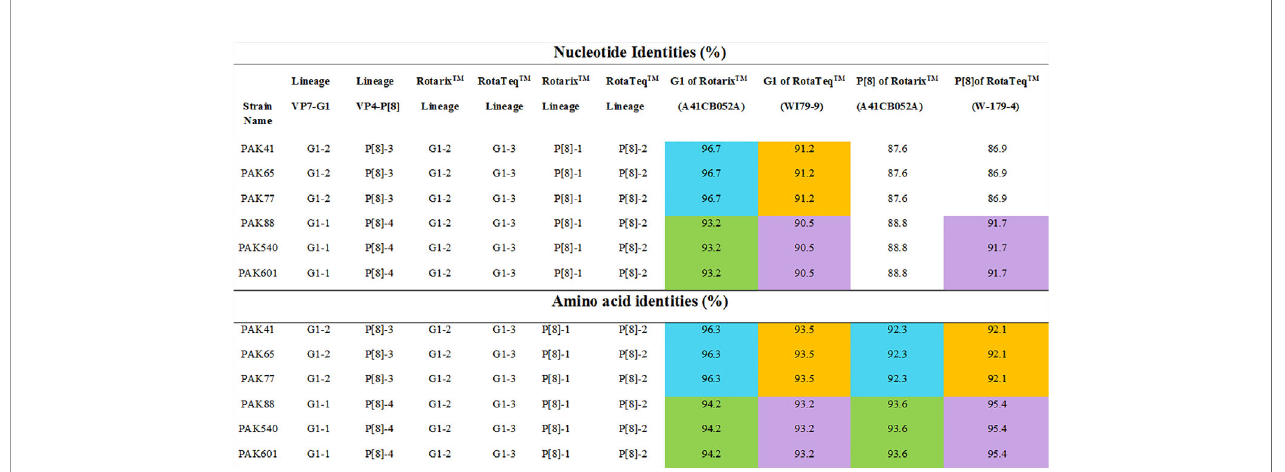
FIGURE 1 | The nucleotides and amino acids differences of VP7 and VP4 proteins of Pakistani G1P[8] strains with rotavirus vaccine strains. The similarities between G1 lineage I to Rotarix ™ and RotaTeq ™ vaccine strains is shown in green and purple colours, respectively. While, the similarities between G1 lineage II to Rotarix ™ and RotaTeq ™ vaccine strains is shown in blue and orange colours,